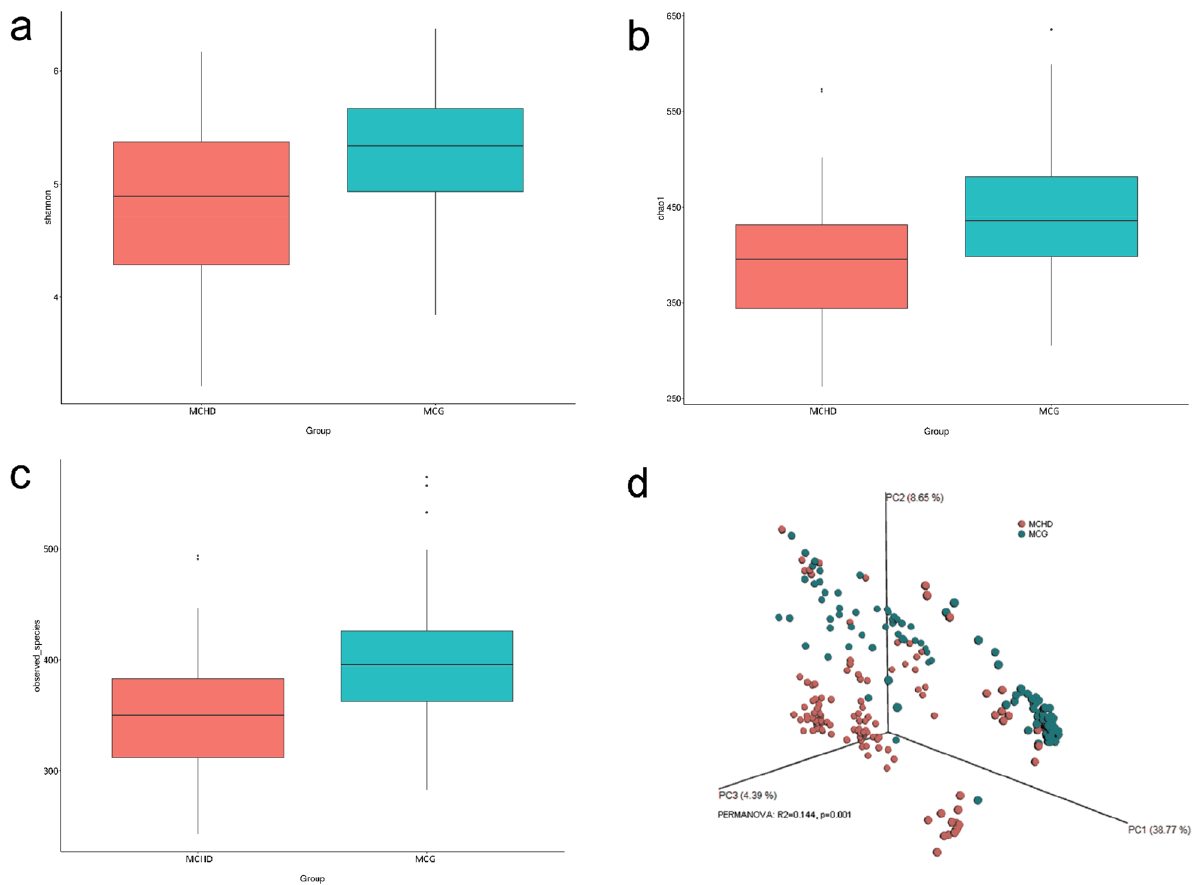
Figure 1. Comparisons of gut microbial alpha-diversity and beta-diversity between mothers of infants with CHD and mothers of infants without CHD. Compared with the controls, gut microbial diversity, as estimated by the Shannon index ( a ), Chao1 index ( b ), and the observed species ( c ), was significantly decreased in mothers of infants with CHD (all p < 0.05). ( d ) PCoA based on unweighted UniFrac distance showed that the overall gut microbiota composition was different between mothers of infants with CHD and controls (R 2 = 0.144, p = 0.001). CHD congenital heart disease, PCoA principal coordinates